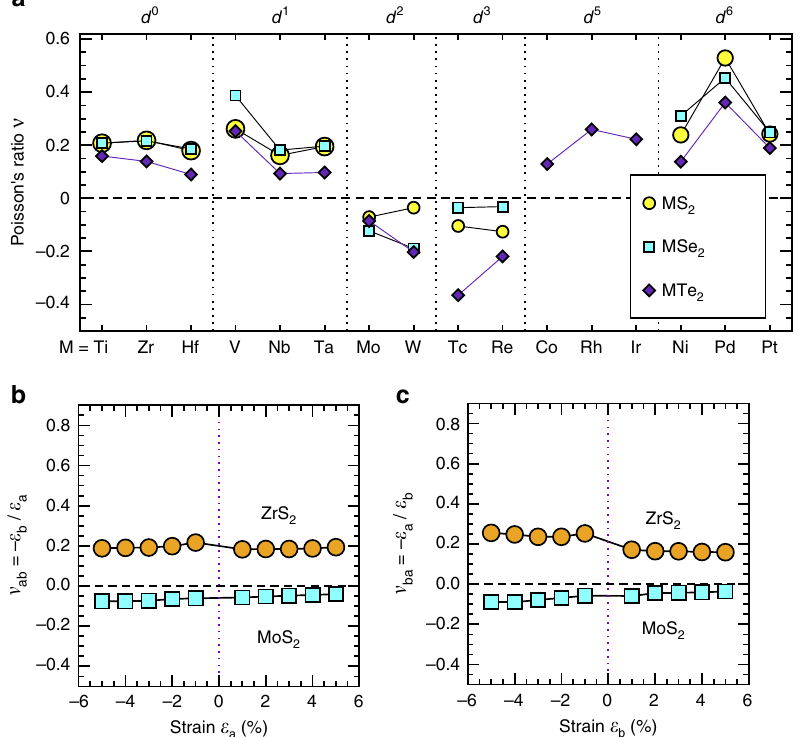
Figure 2 | Poisson’s ratios. ( a ) Poisson’s ratio, n ab ¼ (cid:2) e b / e a , calculated for a 5% strain applied along the a axis (that is, e a ¼ 5%). ( b , c ) Poisson’s ratios for ZrS 2 and MoS 2 as a function of strain applied along the a axis ( b ) and b axis ( c